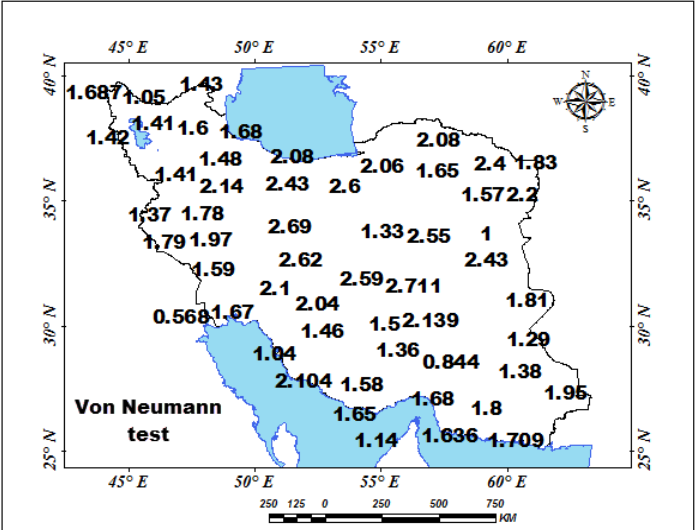
Figure 6. Values of the von Neumann test.